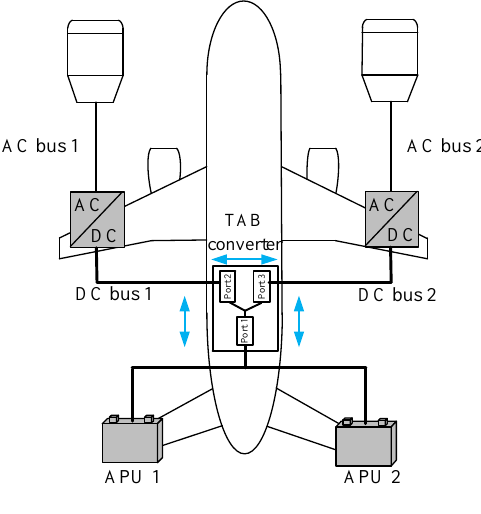
Figure 20. TAB converter in more electric aircraft